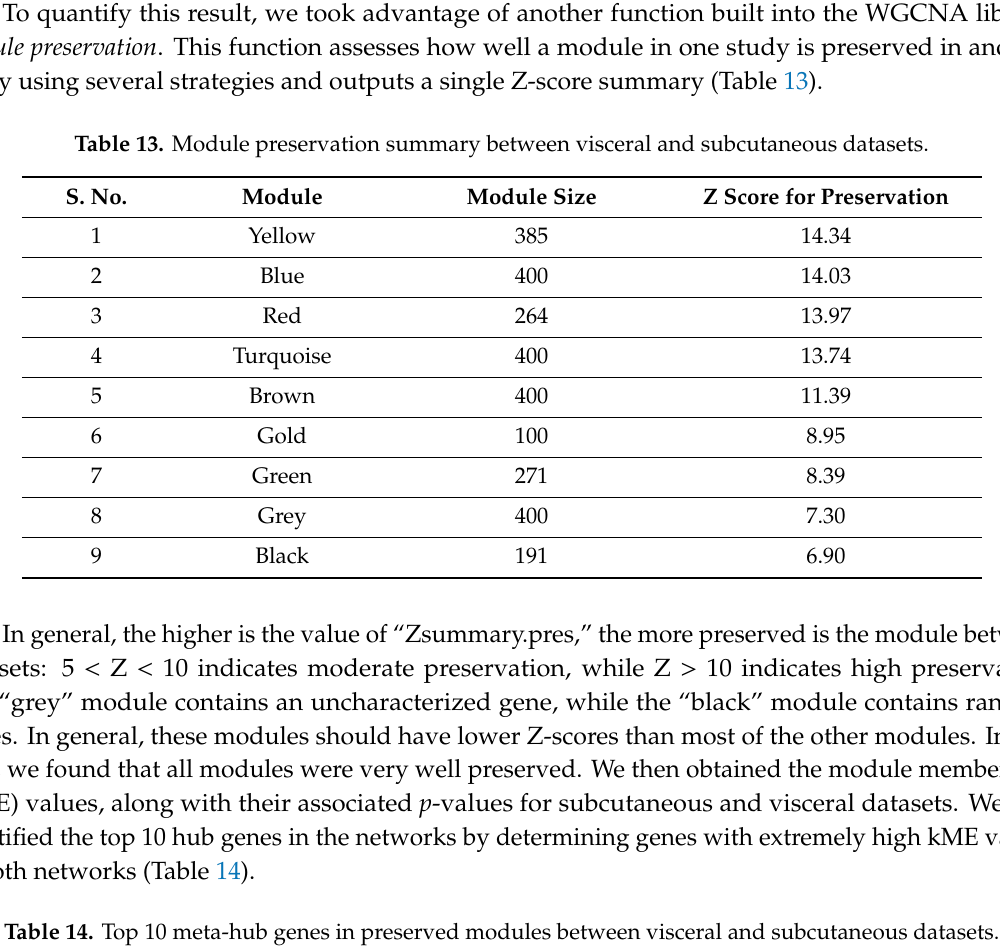
Table 14. Top 10 meta-hub genes in preserved modules between visceral and subcutaneous datasets. S.